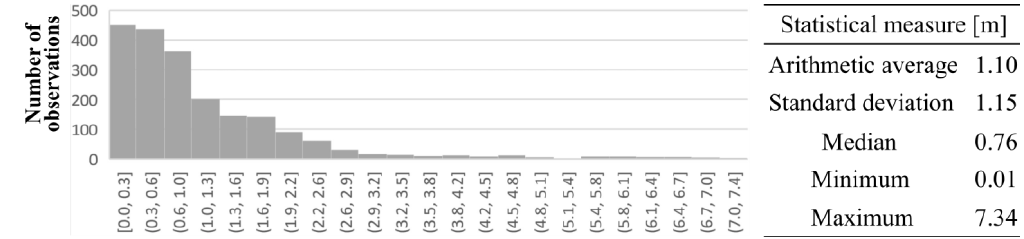
Figure 9. A histogram of error distribution for horizontal positioning by the satellite compass with the sample statistical parameters.